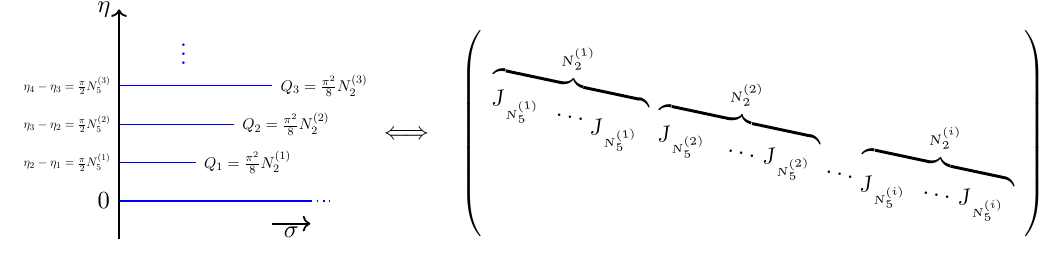
Figure 1 . Electrostatic picture of the